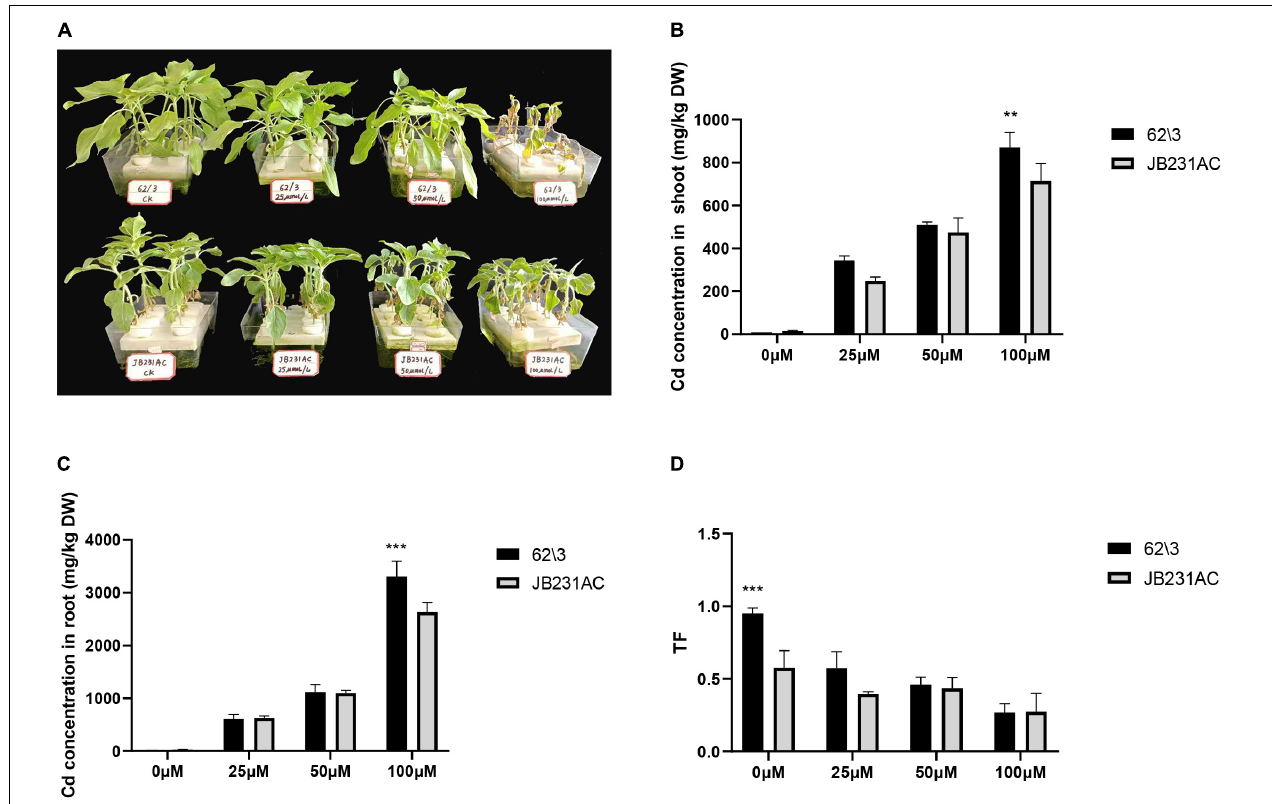
FIGURE 1 | Performance of growth and Cd accumulation of 62\3 and JB231AC genotypes. (A) Growth performance of 62\3 and JB231AC grown hydroponically under Cd stress for 7 days. (B) Cd concentration in the shoots of the seedlings. (C) Cd concentration in the roots of the seedlings. (D) TF (Translocation factor), the ratio of Cd concentration in shoots to that in roots. For (B–D) the statistical analyses were conducted using all the performance data of 62\3 and JB231AC under Cd stress. Data presented are the means ( n = 3), and error bars denote the standard deviations. The asterisk represent the significant difference between 62\3 and JB231AC under one same Cd stress. ** P < 0.01, *** P < 0.001.